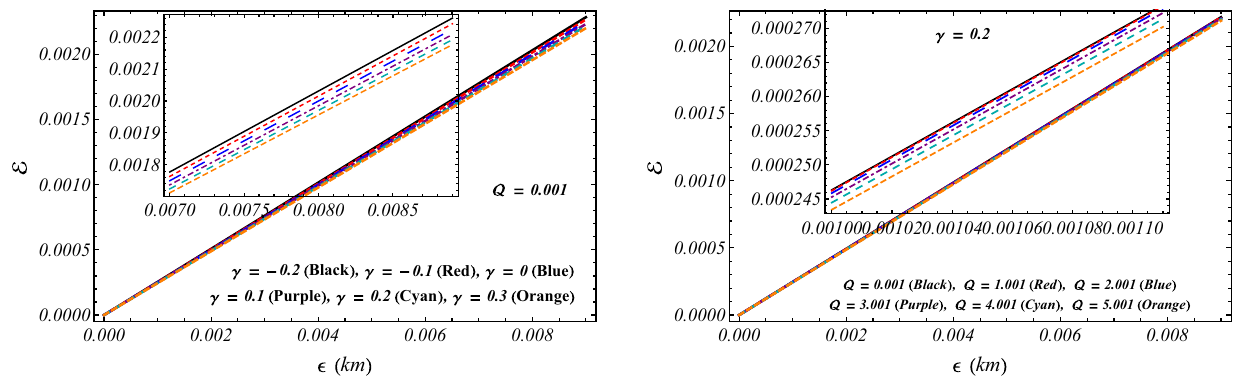
0.0070 0.0075 0.0080